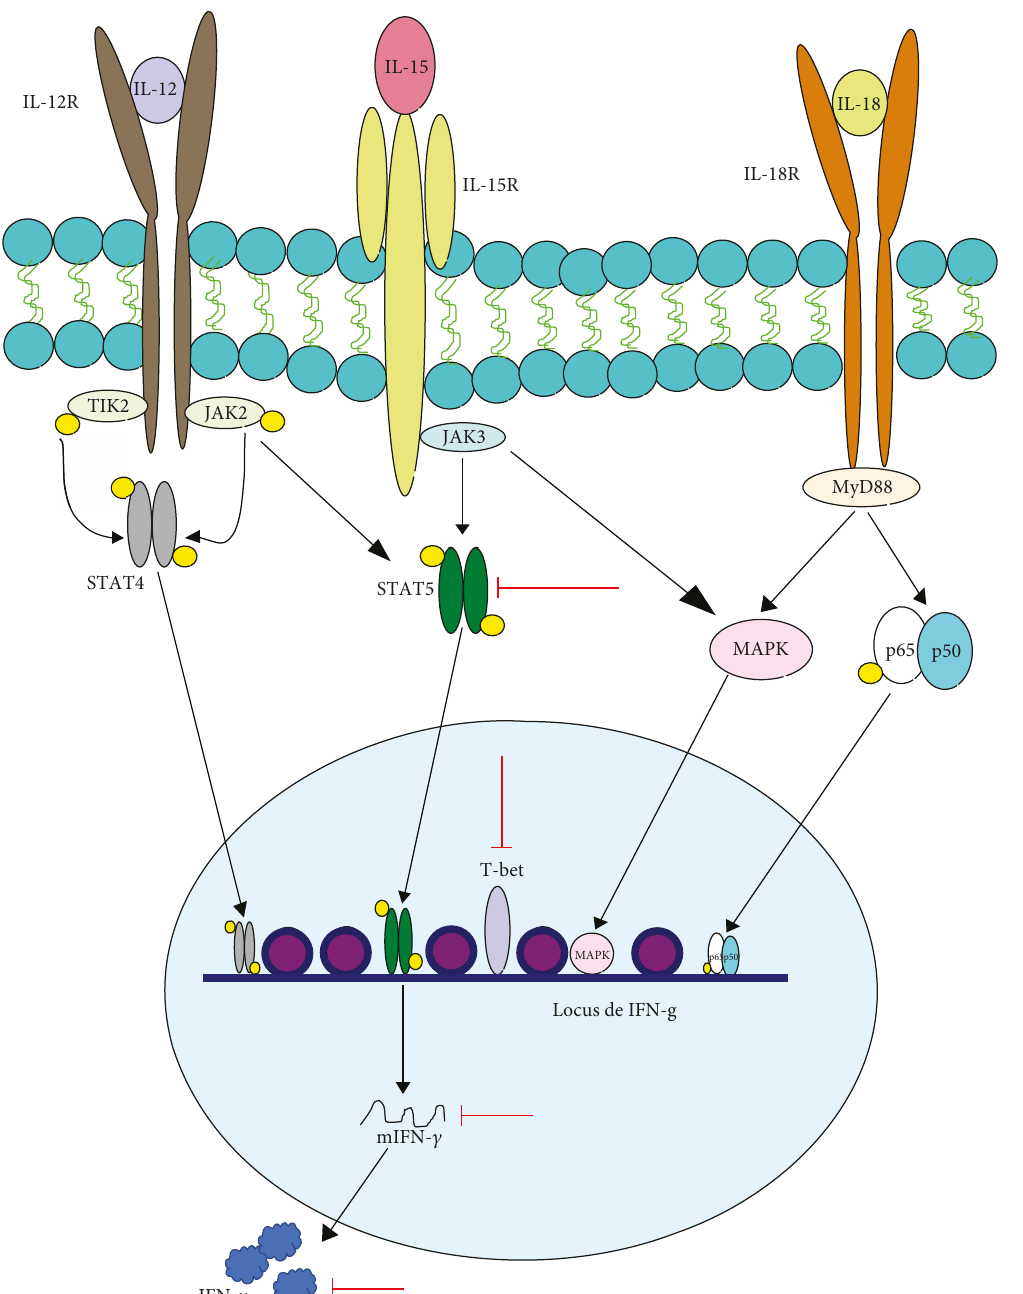
Figure 8: VPA a ff ects IL-12-, IL-15-, and IL-18-mediated IFN- γ production in NK cells. NK cells produce IFN- γ through signaling pathways that are activated by the presence of IL-12, IL-15, and IL-18. In response to IL-12, STAT4 is activated and STAT5 is phosphorylated, while IL-15 activates both STAT5 and the MAPK pathway and IL-18 induces NF- κ B and the MAPK pathway. An intermediate of this path is p38 (not shown), which stabilizes the IFN- γ mRNA. This promotes a synergistic e ff ect for the production of this cytokine. On the other hand, STAT5 activation promotes the expression of T-bet, recognized as the master regulator for IFN- γ expression. VPA also interferes with the production of this cytokine by reducing STAT5 phosphorylation and T-bet expression. Green arrows indicate the processes, molecules, or mediators in the signaling pathway that are augmented and/or promoted by VPA. Red arrows indicate processes, molecules, or mediators in the signaling pathway that are inhibited by